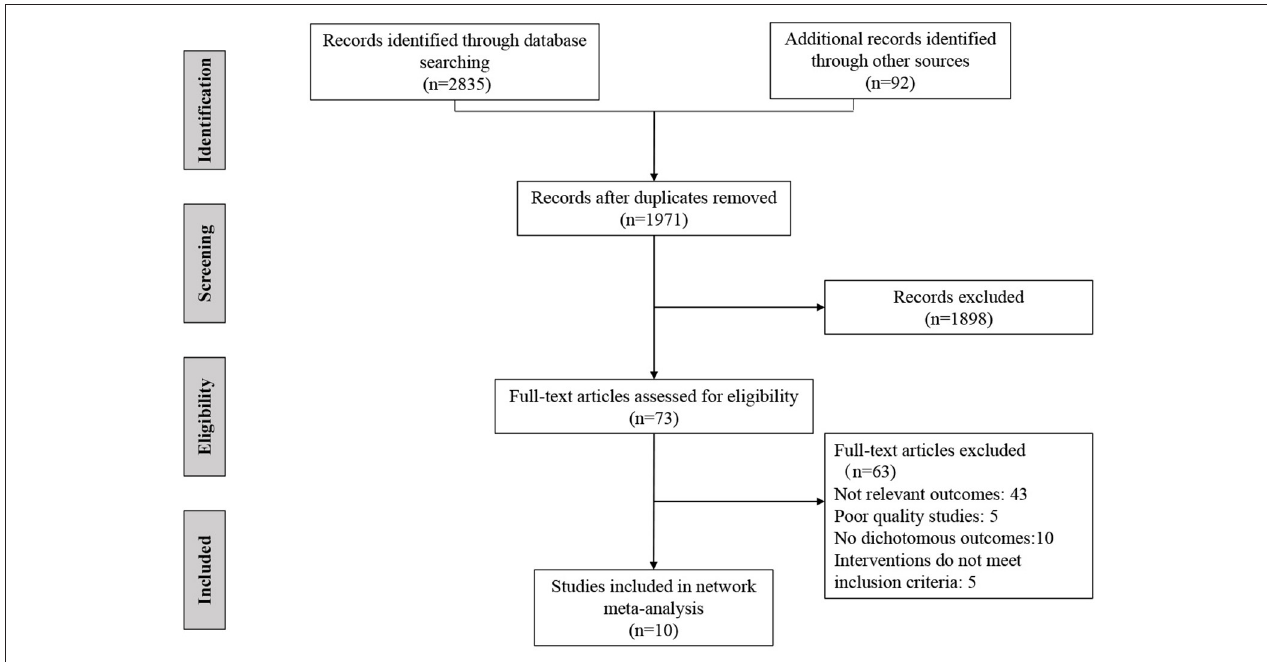
FIGURE 1 | Flow diagram of literature search and